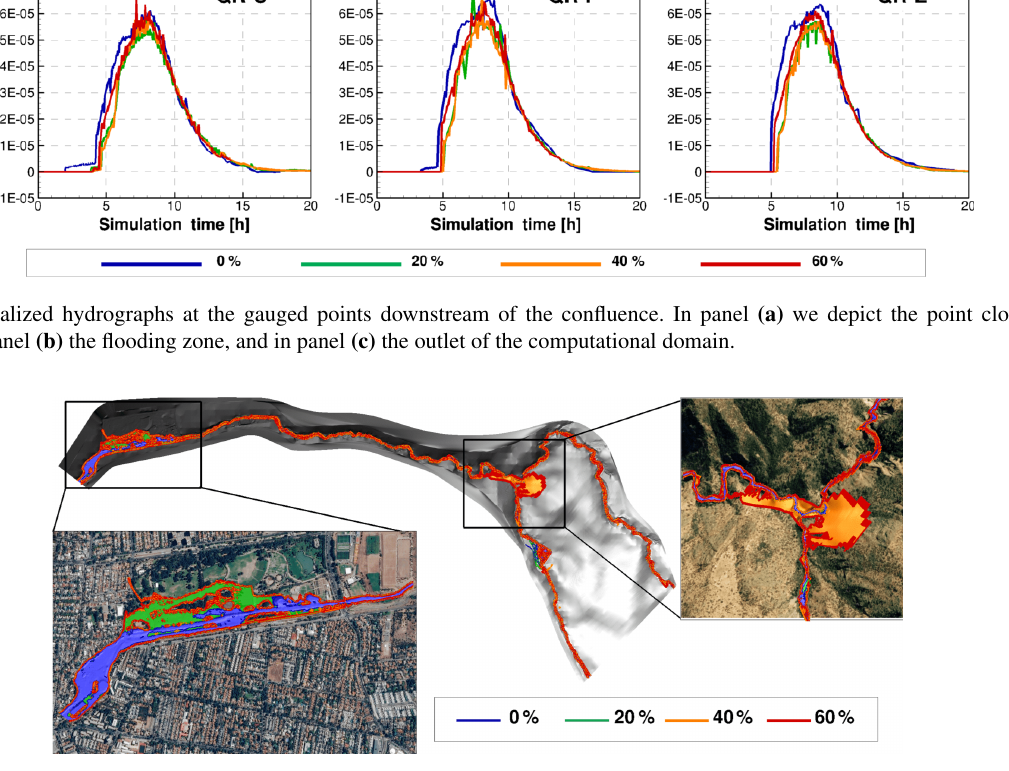
Figure 9. Contours of the flooded area for different sediment concentrations along the channel, and in the city of Santiago. Image of the terrain from © Google Earth.